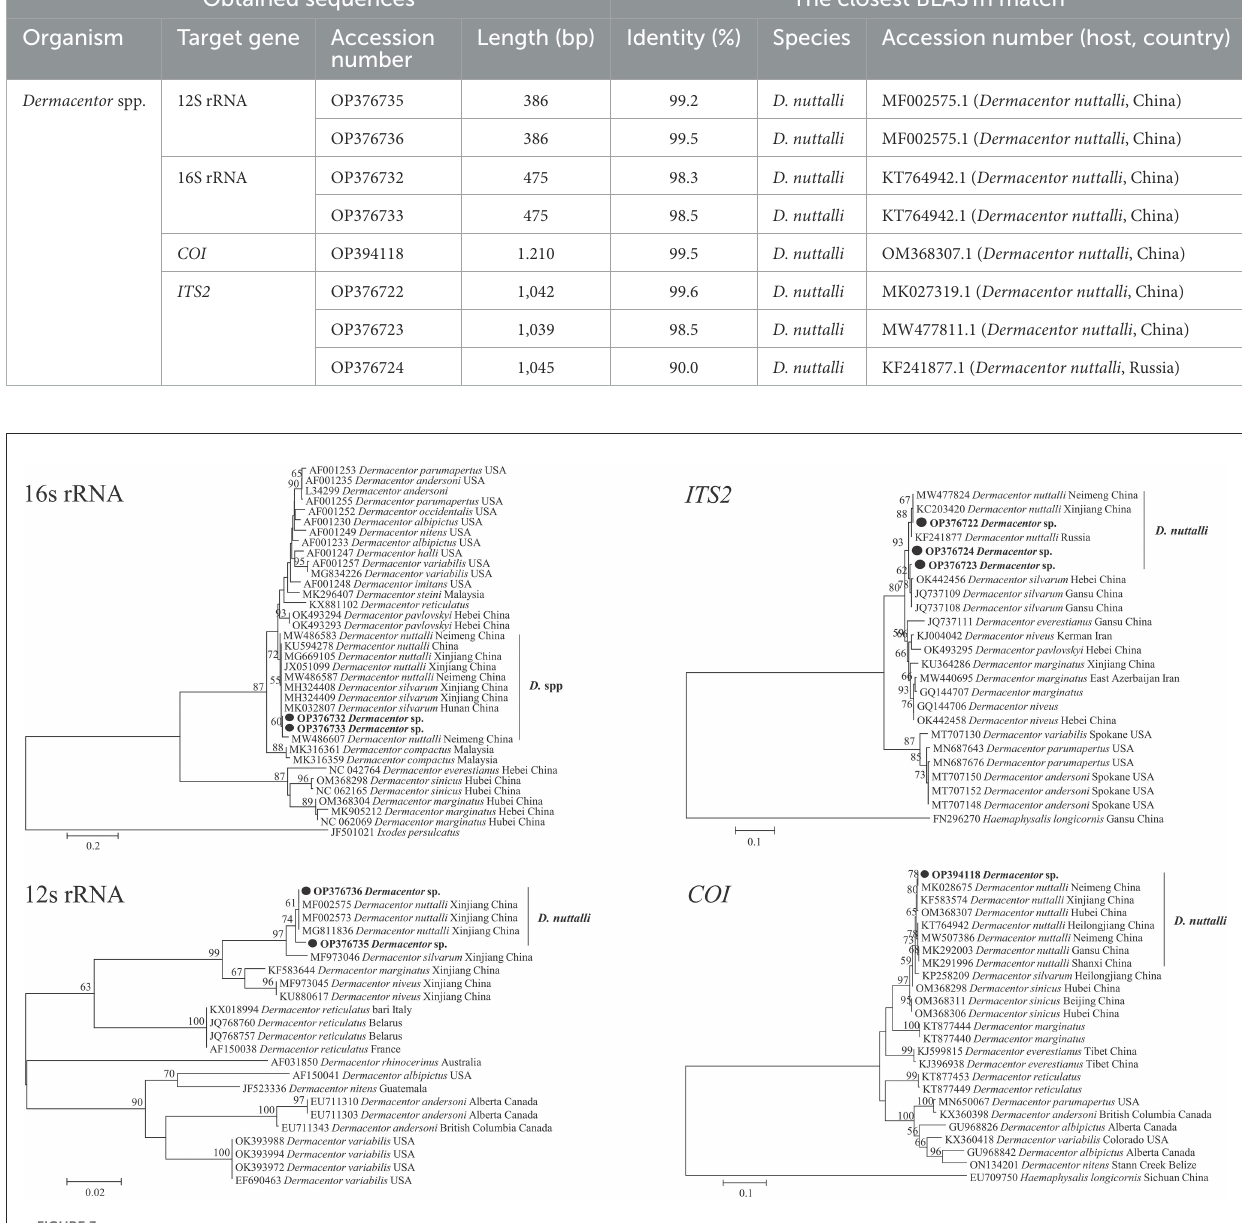
control and D. nuttalli DNA stored in our laboratory was used as a positive